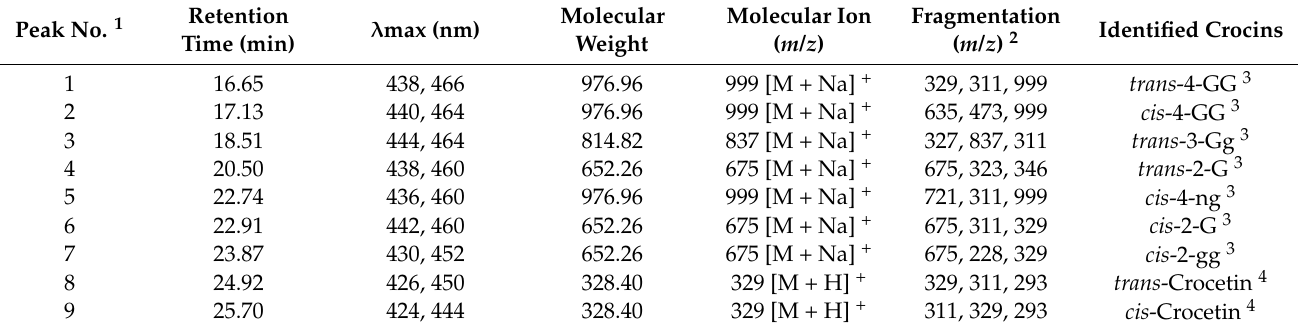
Table 3. Identification of crocins relative compounds in raw materials and enzyme hydrolyzed products of GFW by using HPLC-DAD-ESI-(+)-MS